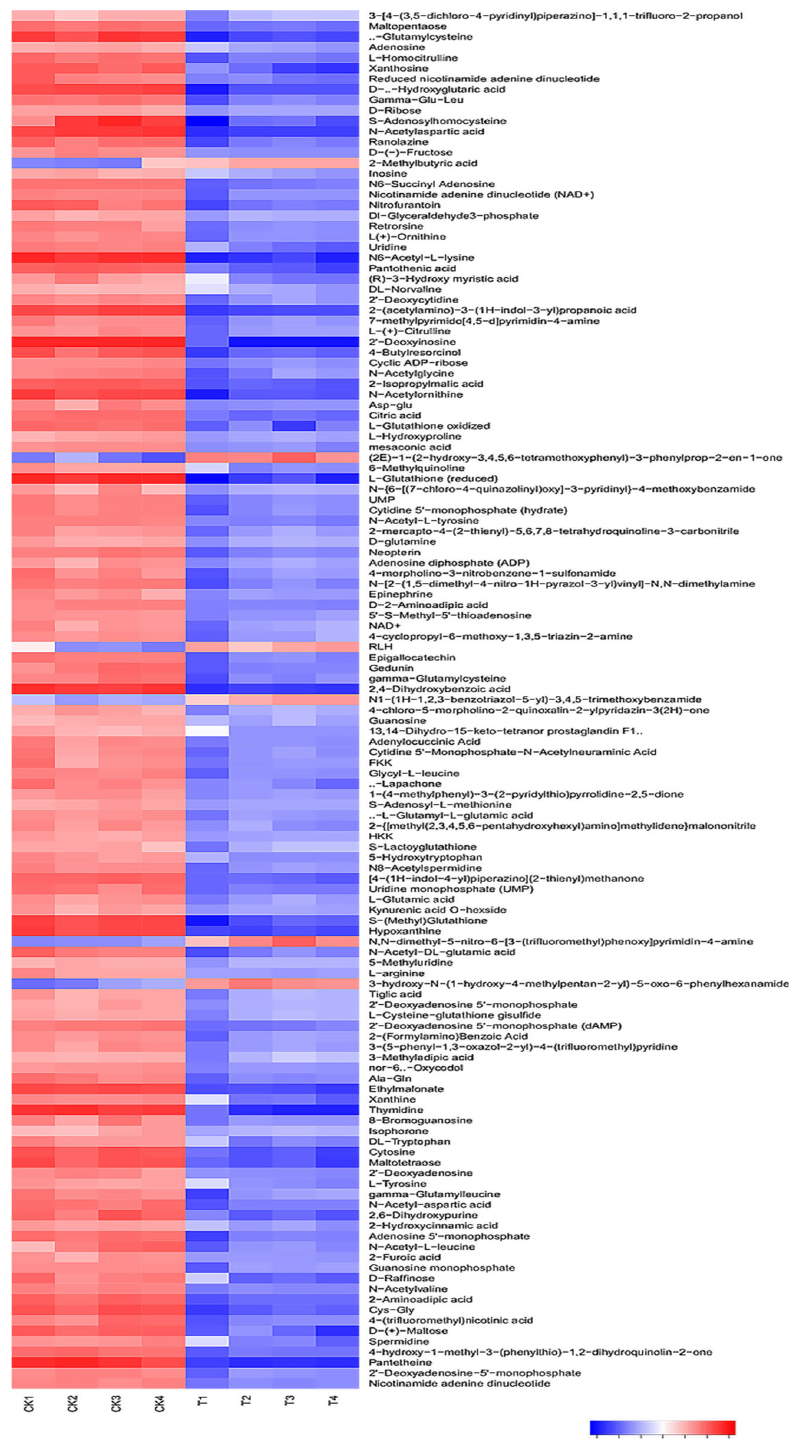
Figure 8. Heat map of differential metabolites cluster. Each row represents one differential metabolite identified. The color represents the metabolite abundance, the red areas in the heat map represent the higher content of metabolites, and the blue areas are the lower concentrations. CK and T refer to DIW and PALA (0.2%) treatment,